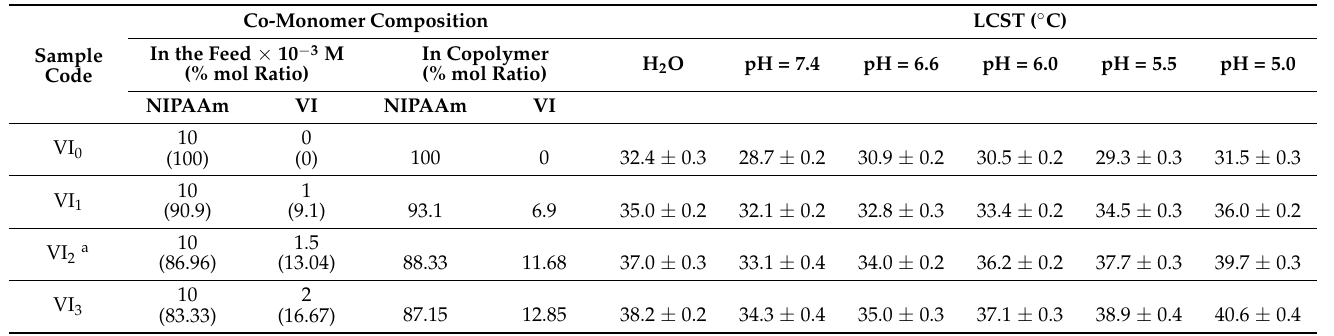
Table 1. Composition of co-monomers in the feed and in the copolymer and dependence of LCST on the co-monomer molar ratio (concentration of copolymer solution was 1%, w / v